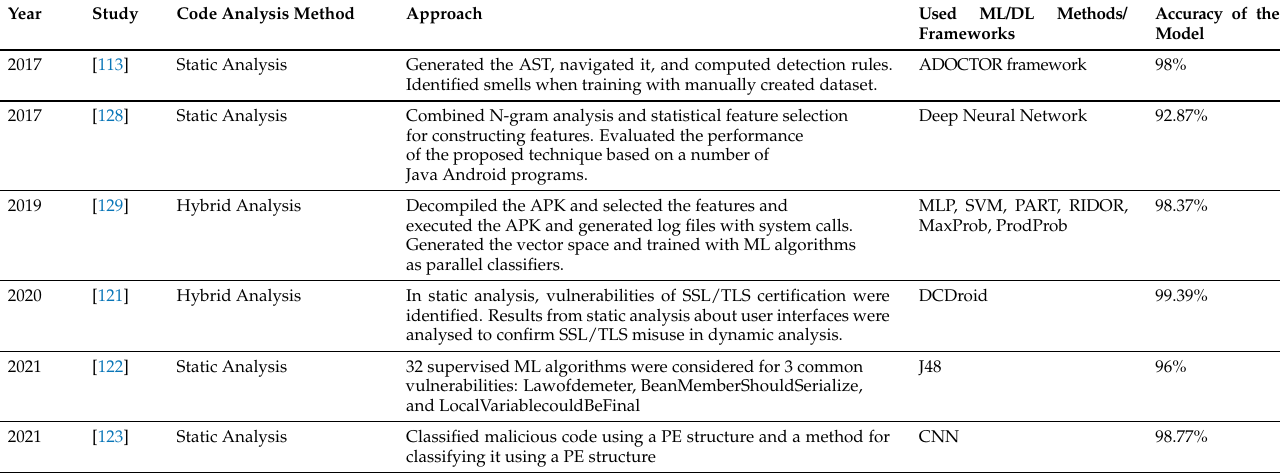
Table 11. Android vulnerability detection mechanisms (model accuracy is above